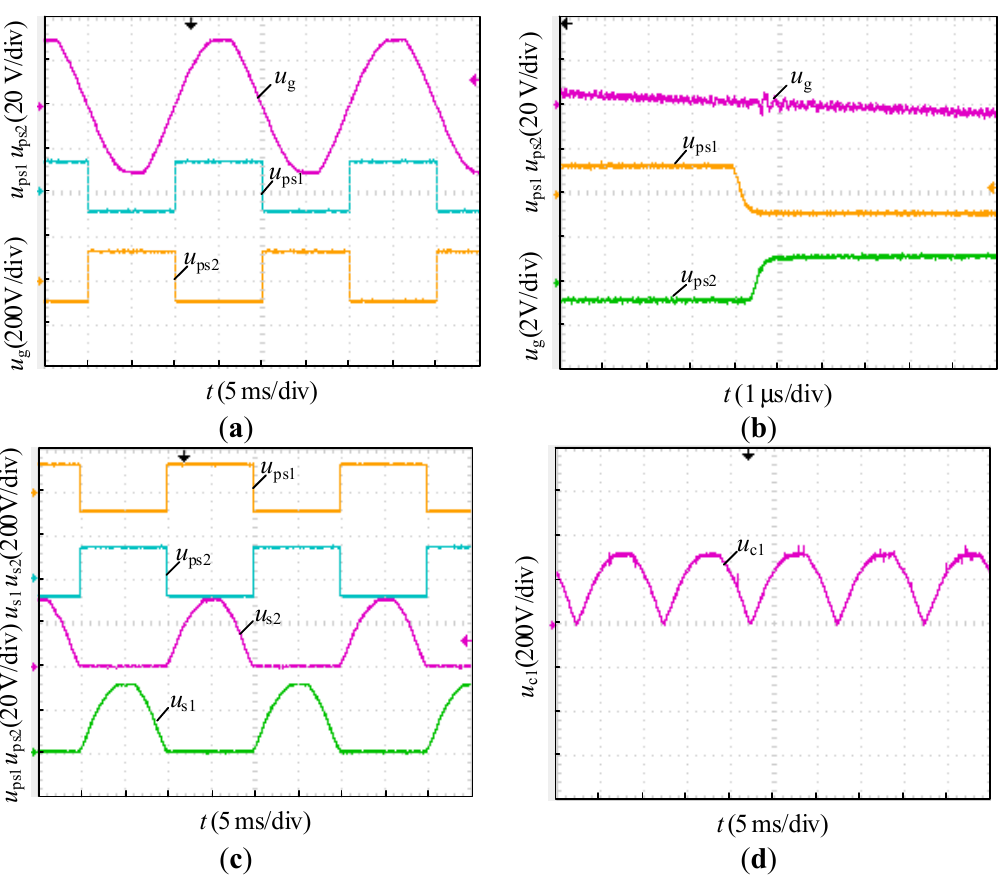
Figure 24. High-frequency Line-frequency operating waveforms of BSS-FBC in discharging mode: ( a ) Grid voltage and driving pulse of S point of grid voltage for grid voltage and driving pulse of S voltage stress of S , S ; ( d ) Voltage of dead time 1 2